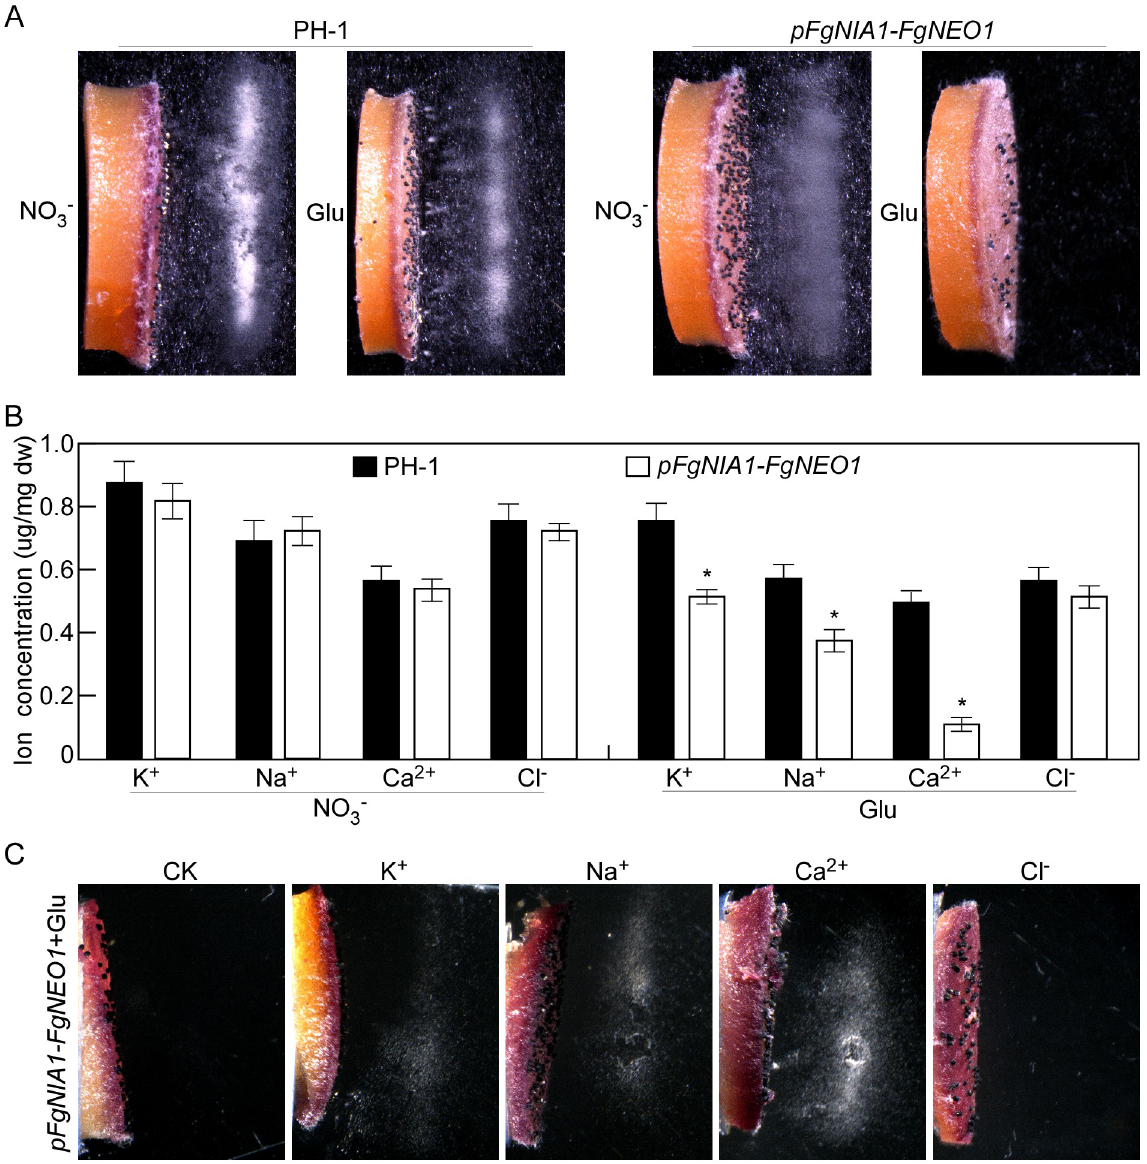
Fig 9. FgNeo1 is essential for ascospore discharge in an ion-dependent manner. (A) Ascospore discharge of perithecia harvested from PH-1 and pFgNIA1-FgNEO1 cultured on carrot agar plates with NO 3- or Glu. (B) Measurement of the ion concentration in asci of the indicated strains by spectrophotometrically. Error bars represent the SD and asterisks indicate statistically significant differences ( p < 0.01). (C) Ascospore discharge of perithecia harvested from pFgNIA1-FgNEO1 cultured on carrot agar plates with Glu by adding exogenous ions.